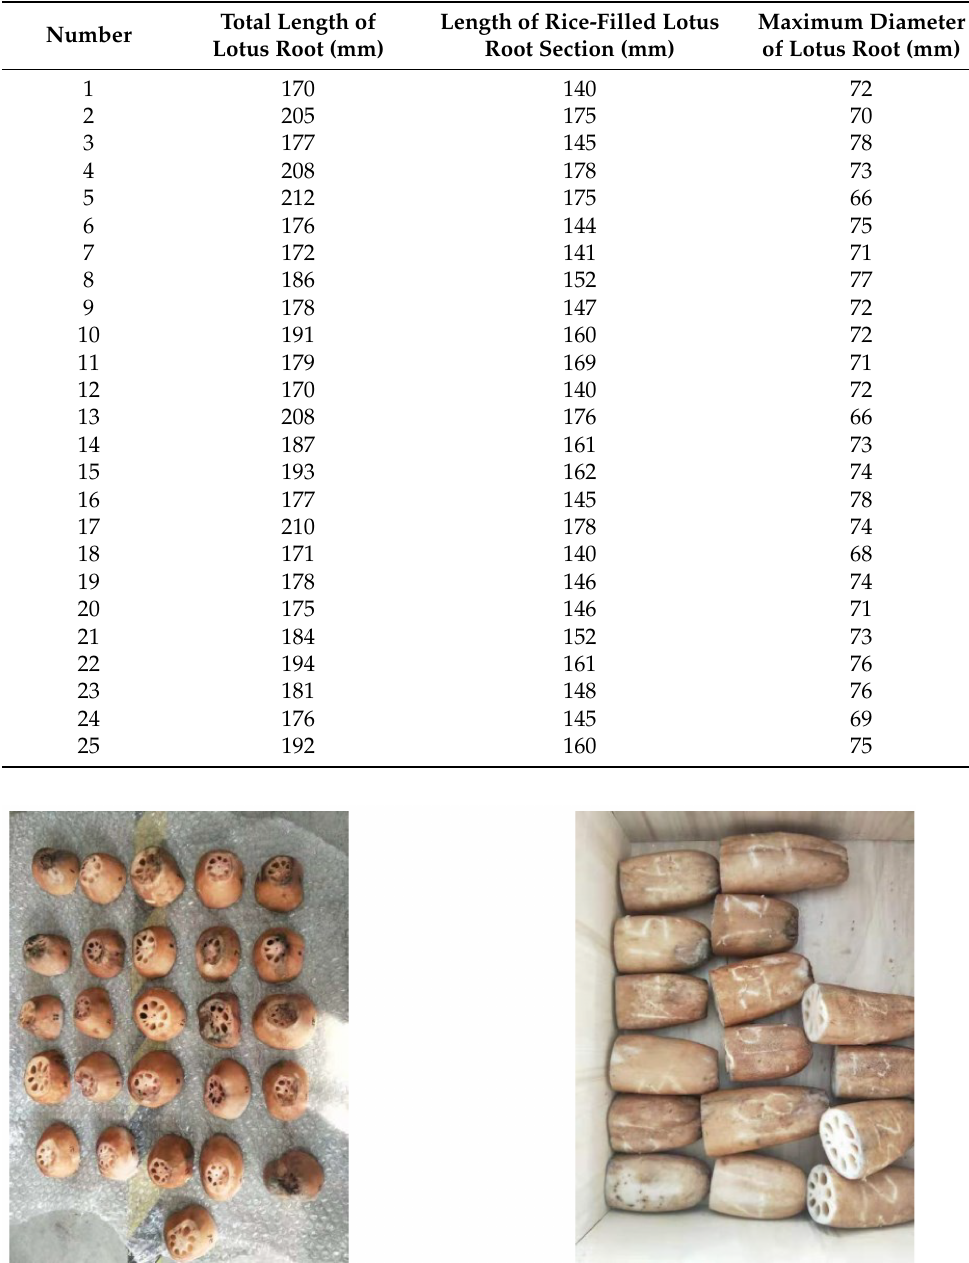
Figure 6. Lotus root sample number